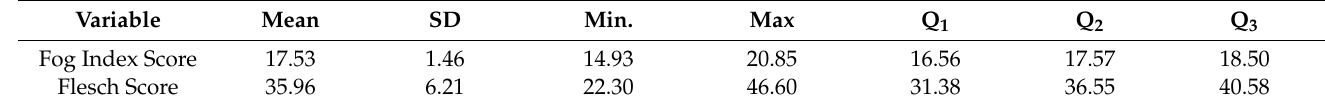
Table 3. Descriptive